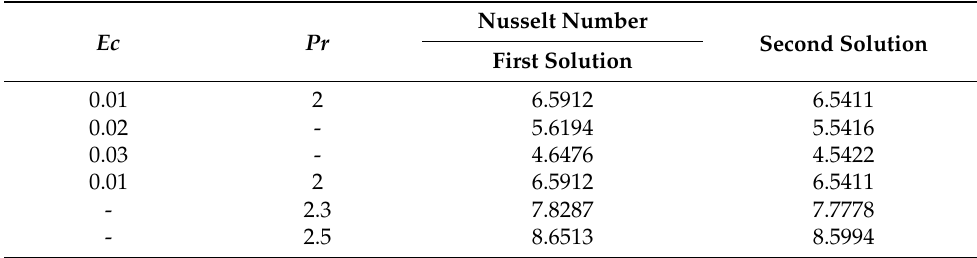
Table 2. Numerical results of heat transfer rate for various values of A = 0.1, Ec = 1, and Pr = 1.